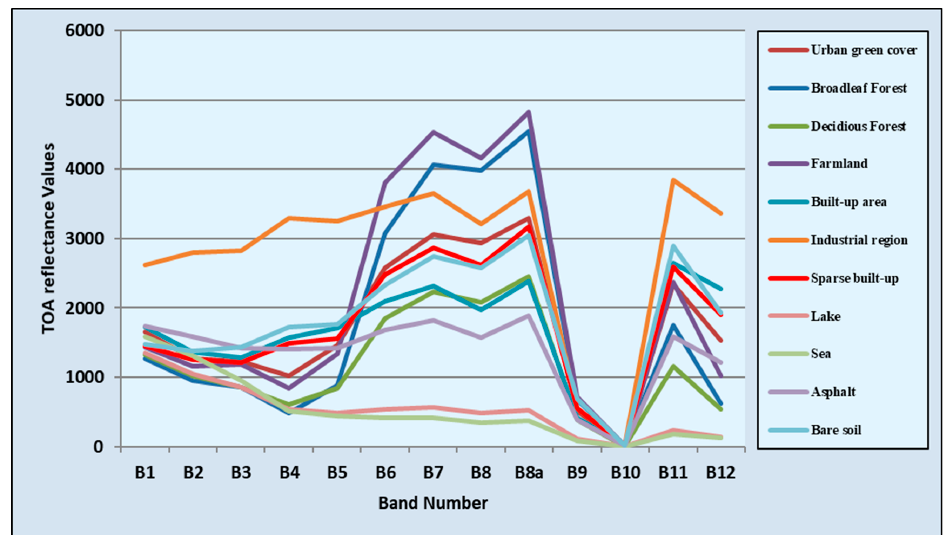
Figure 2. Spectral reflectance curves of different land cover/use (LCU) types, according to the Sentinel-2A image bands (top of atmosphere reflectance values derived from 12-bit resolution satellite image).